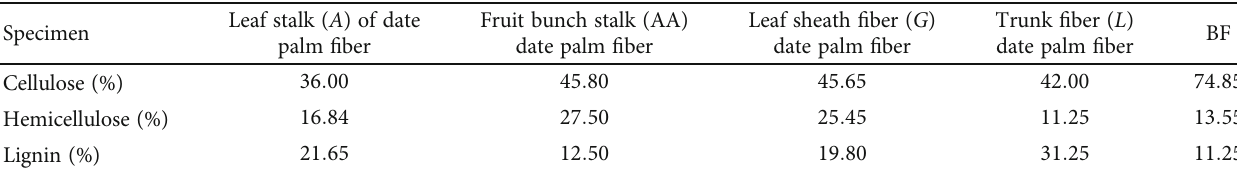
Figure 1: Applications of polymer matrix composites. Table 1: Chemical composition of (DPT) and